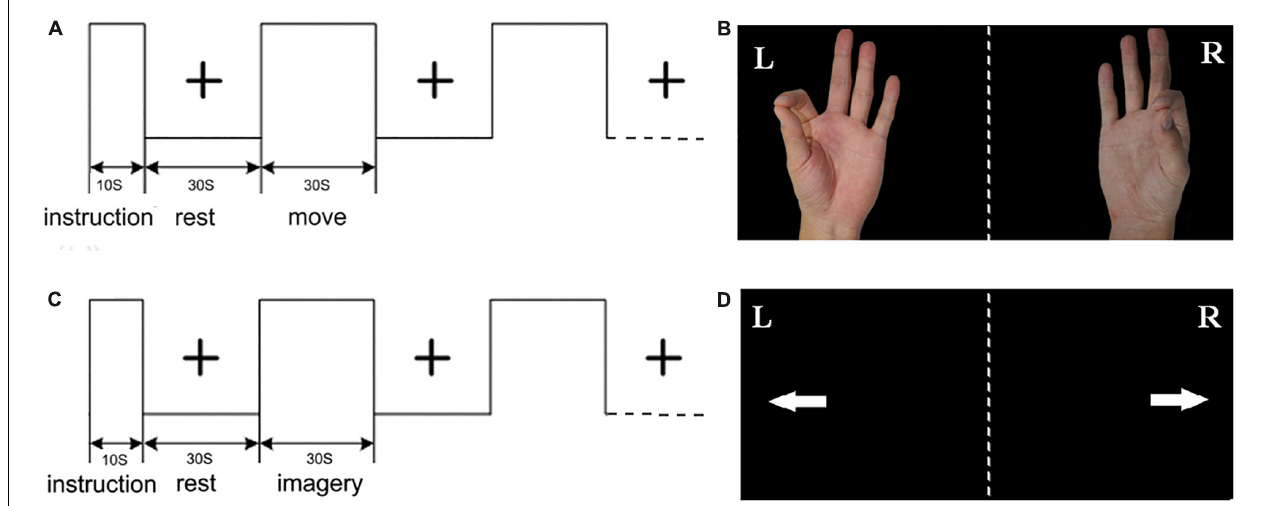
FIGURE 1 | Experimental design: (A) the block of motor execution (ME); (B) picture of right/left hand finger during ME; (C) the block of motor imagery (MI); (D) picture of right/left arrow during MI; each run included a 10 s instruction introduction period and five blocks, and each block included 30 s of rest and 30 s of task.